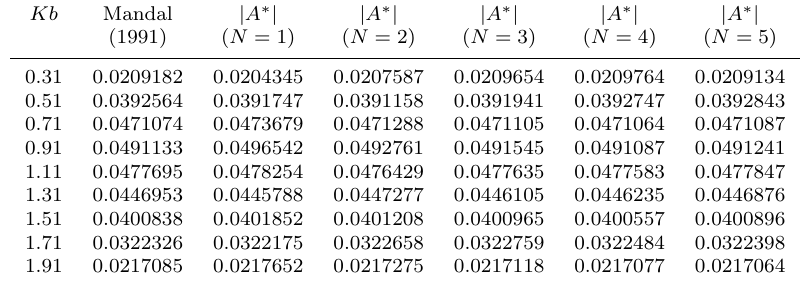
Table 2. Values of | A ∗ | against Kb for different N for a submerged plate with a/b = 0 . 2 and c/b = 0 . 5